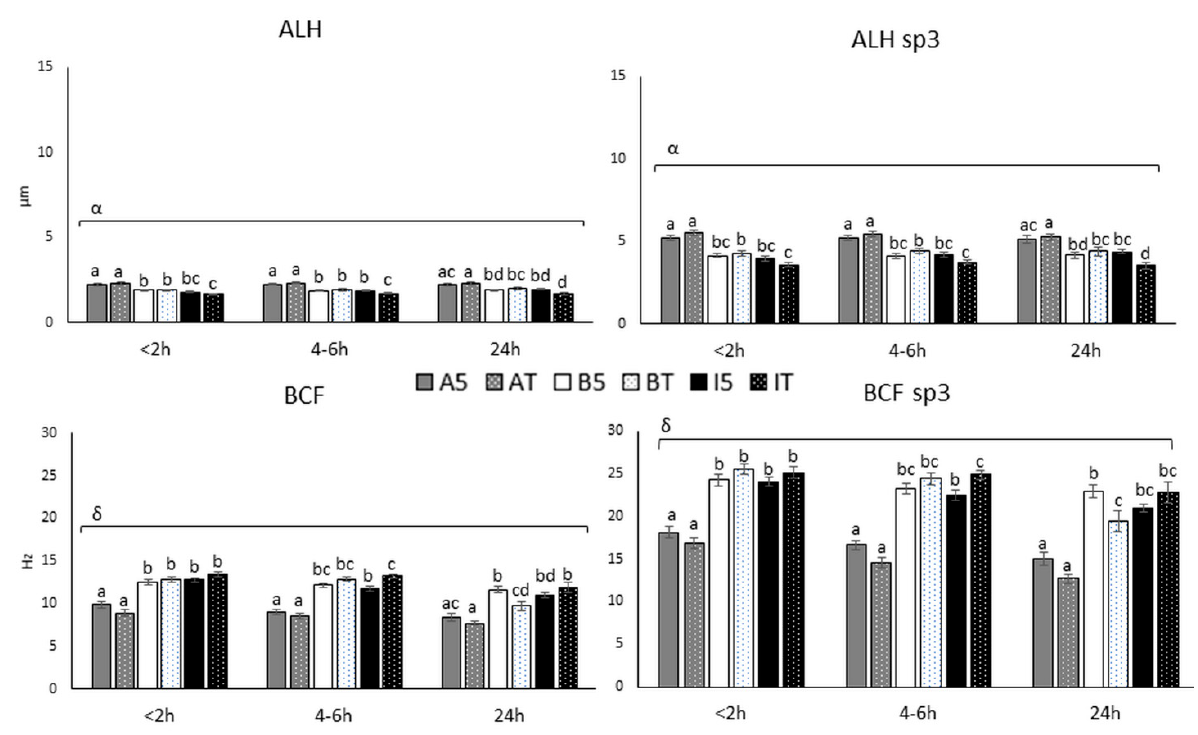
Figure 4. ALH and BCF parameters of all subpopulations and specifically sp3, at three different time-windows until assessment (<2, 4–6 and 24 h), with three different extenders (AndroMed ® , BIOXcell ® and INRA96 ® ) and at two holding temperatures (refrigeration vs. room temperature). Bars with different letters mean statistical significantly different values ( p < 0.05) among the six combinations extender by holding temperature, at each time window (ANOVA analyses). Square brackets over the bars highlight statistically significant effects ( p < 0.05; from GLM analyses) of the factors or factors’ interactions (Greek letters), during the time-windows embraced. Abbreviations: CASA: Computer Assisted Semen Analyses; ALH: Amplitude of head lateral displacement average; BCF: Beat cross frequency average; sp3: fast subpopulation. A: AndroMed ® ; B: BIOXcell ® ; I: INRA96 ® ; T: room temperature; 5: refrigeration at 5 ◦ C. < 2h: time of assessment <2 h after collection; 4–6 h: time of assessment 4–6 h after collection; 24 h: time of assessment 24 h after collection; α : interaction extender by